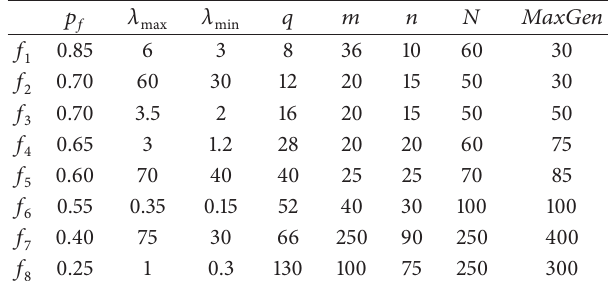
Table 1: Properties of the benchmark problems. Dimension Continuous Differentiable Separable Scalable